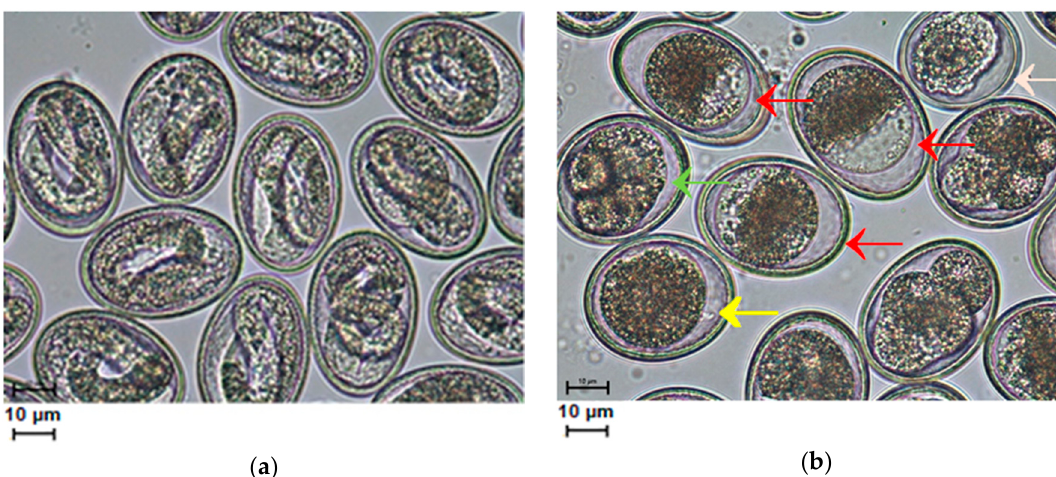
Figure 3. Developmental degree of Ascaris suum eggs after 72 h exposure to the drug and 20 days of in vitro culture in 0.05 M HCl: ( a ) Control test, 0.1% DMSO—eggs mainly in the stage of correctly developed larvae L 2 ; ( b ) 10 mM solution of the drug—egg development was largely arrested at the one-cell stage ( ← ) or irregular cell division ( ← ) was observed, it resulted in atypical blastomeres inside ( ← ) and in a change in the shape of the eggs ( ← ) (40× magnification, scale 10 μ m).